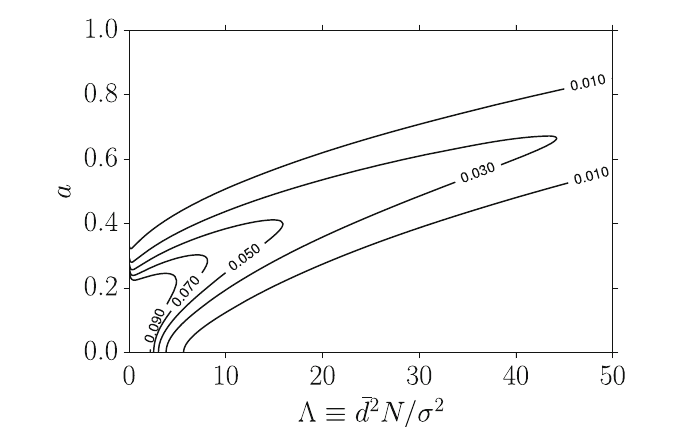
Fig. 10 Equal-probability contour plot for the frequentist detection statistic Λ ≡ ¯ d 2 N /σ 2 for a signal with amplitude a > 0. The contours correspond to the values p ( Λ | a , M 1 ) = 0 . 01, 0.03, 0.05, 0.07, and